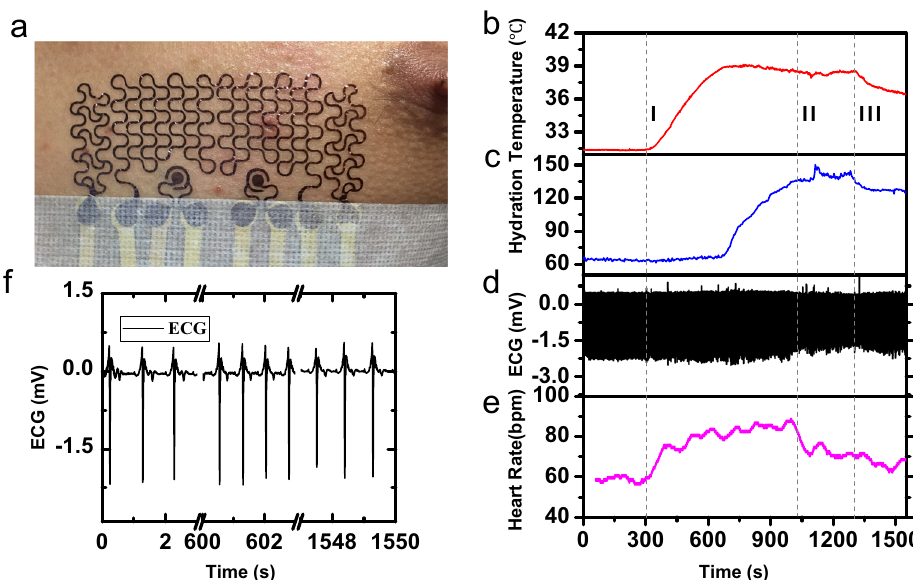
Fig. 5 Investigation of sweat artifacts. a A 1.5- μ m-thick multifunctional e-tattoo transferred on human chest and connected to data acquisition systems. b – e Skin temperature, skin hydration, ECG, and heart rate simultaneously captured by the e-tattoo before, during, and after the subject was subjected to heating and calorie intake. f Zoomed-in ECG signals at different time